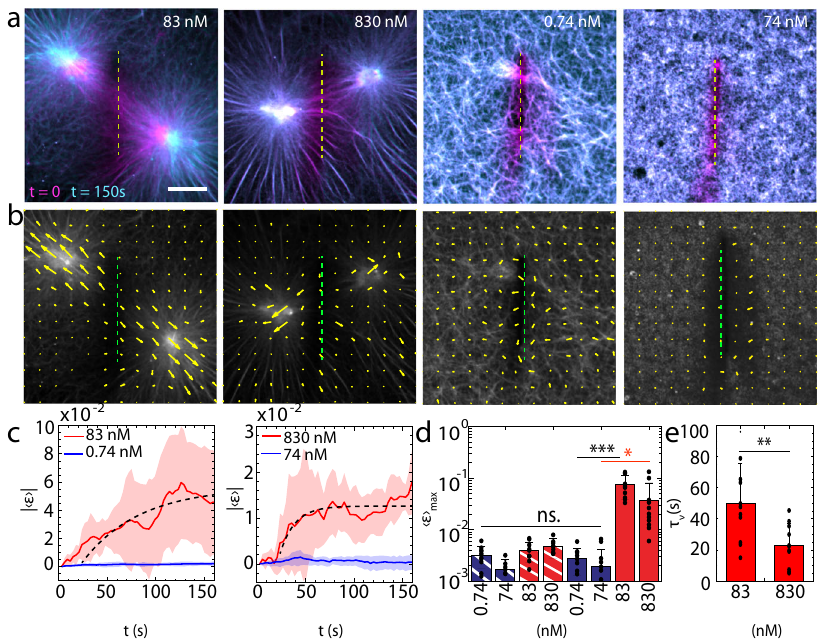
Fig. 3 | Branched F-actin networks prevent the accumulation of myosin- induced mechanical tension. a Actin overlay pre- (magenta, t = 0) and post- ablation (cyan, t = 150s). yellow dashed lines show the ablation regions. b Actin velocity fi eld quiver plot for post ablation ( t = 150s). c Absolute valued mean strain ( ∣ ε h i ∣ )vs.timeforpost-ablation( t >15s)83nMmDia1vs.0.74nMArp2/3-nucleated F-actin (left), and 830nM mDia1 vs. 74nM Arp 2/3-nucleated F-actin (right) (N=10 independent experiments for each condition). Shaded regions indicate s.d. of the mean. d Maximum mean strain ( ε h i max ) for actin post-ablation for 83nM/830nM